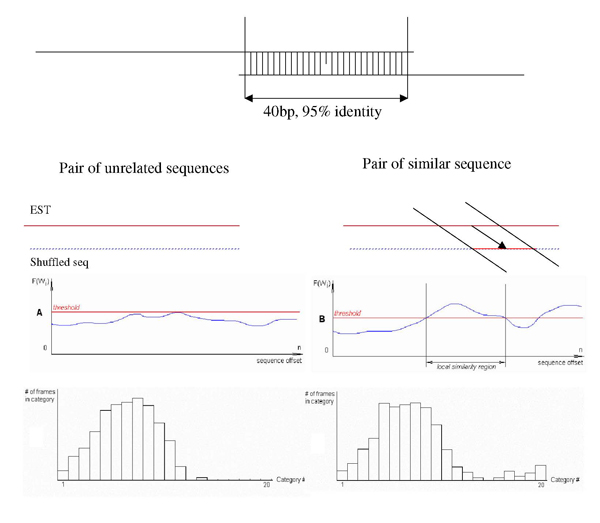
Generation of simulated non-matching (A) and matching (B) pairs in the process of algorithm development. A non-matching pair of sequences is generated by shuffling a randomly picked EST. A matching pair is generated by coping a stretch of 40 base pairs with one mismatch from one sequence to another. For each pair the local similarity function F(Wi) profile and categorized distribution of its values is generated.